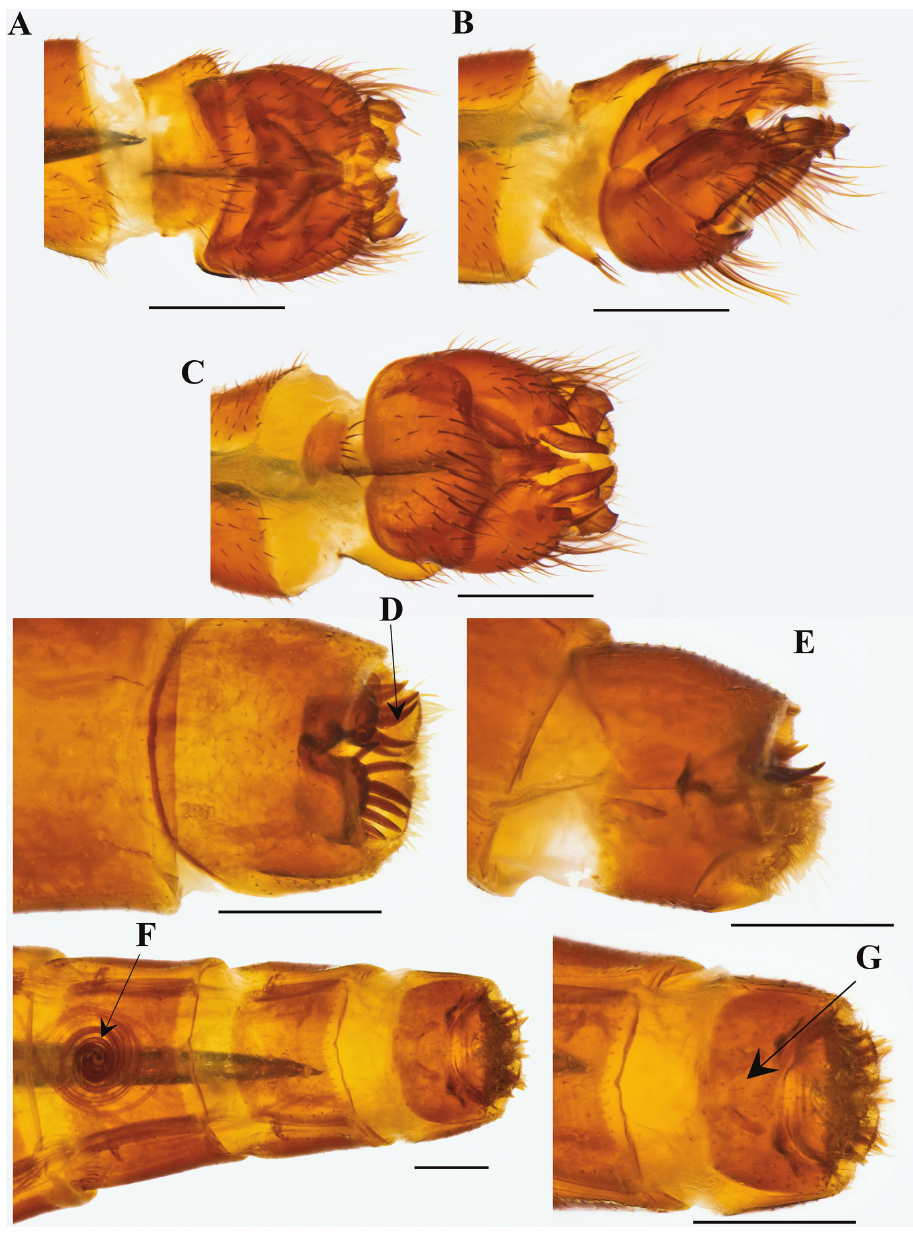
Figure 25. Saropogon pyrodes sp. nov. terminalia. Male (USNMENT01819155): A dorsal view 75× B lateral view 75× C ventral view 75×; female (UAIC1128818): D dorsal view 80×, arrow indicating acanthophorites (spines) E lateral view 95× F ventral view of T6–9 40×, arrow indicating spiral sperma- thecal reservoir G ventral view of T8–9 80×, arrow indicating “X” shaped furca. Scale bars: 1